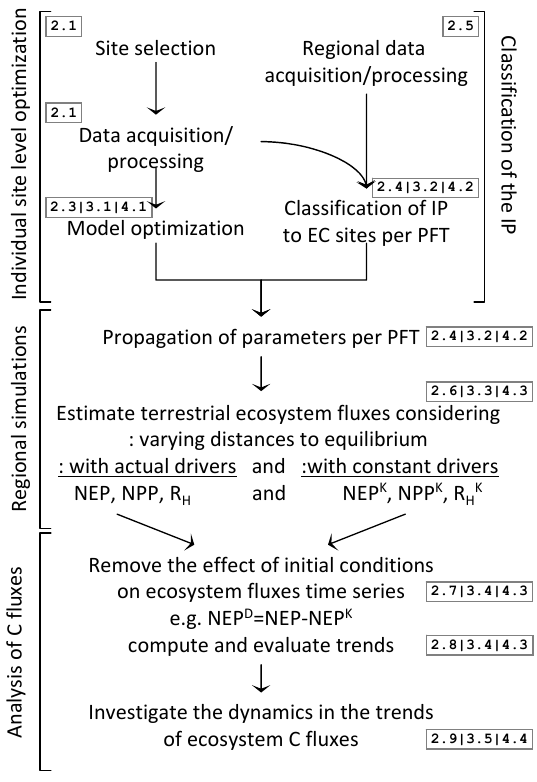
Fig. 1. Workflow of the current analysis: from site level observa- tions to regional dynamics of ecosystem C fluxes. The model-data integration followed at site level yields optimized parameter vec- tors used for regional simulations. The propagation of parameter vectors is dependent on the classification results of each IP grid- cell according to site level characteristics, which support the sen- sitivity analysis to the initial conditions. Ultimately, the evalua- tion of trends in ecosystem fluxes quasi-independently from initial conditions allows the decomposition of modeled ecosystem fluxes into component fluxes and investigating the underlying dynamics of NEP trends. The numbers in gray boxes indicate the sections of the manuscript focusing on the different aspects of each step: materials and methods (2.x); results (3.x); and discussion